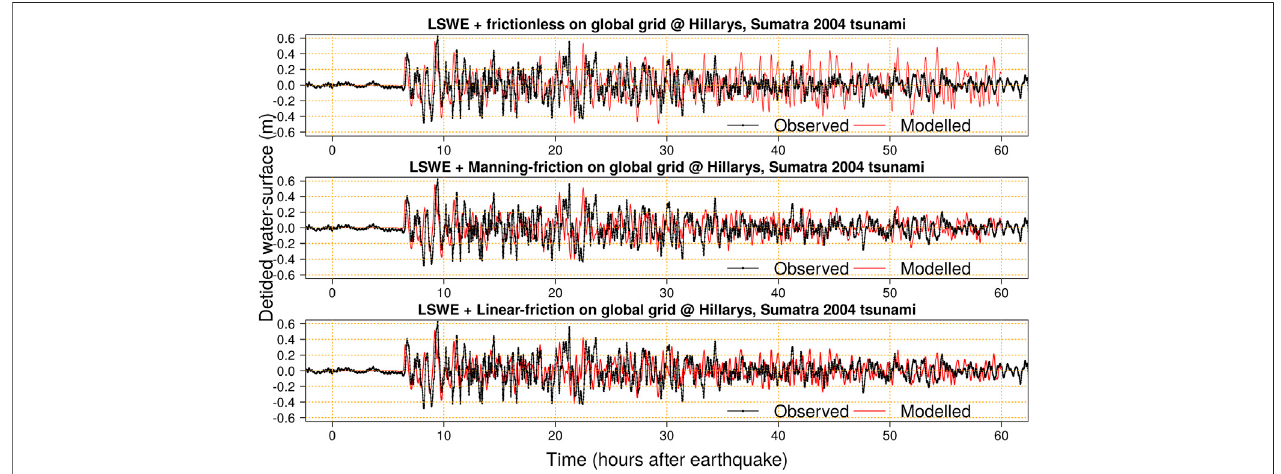
FIGURE 8 | Simulations and observations of the Sumatra 2004 tsunami at Hillarys in Western Australia. All simulations use the Sumatra 2004 F07 source model. Top: Using the frictionless LSWE on the global grid. Middle: Using LSWE with Manning-friction on the global grid. Bottom: Using LSWE with linear-friction on the global